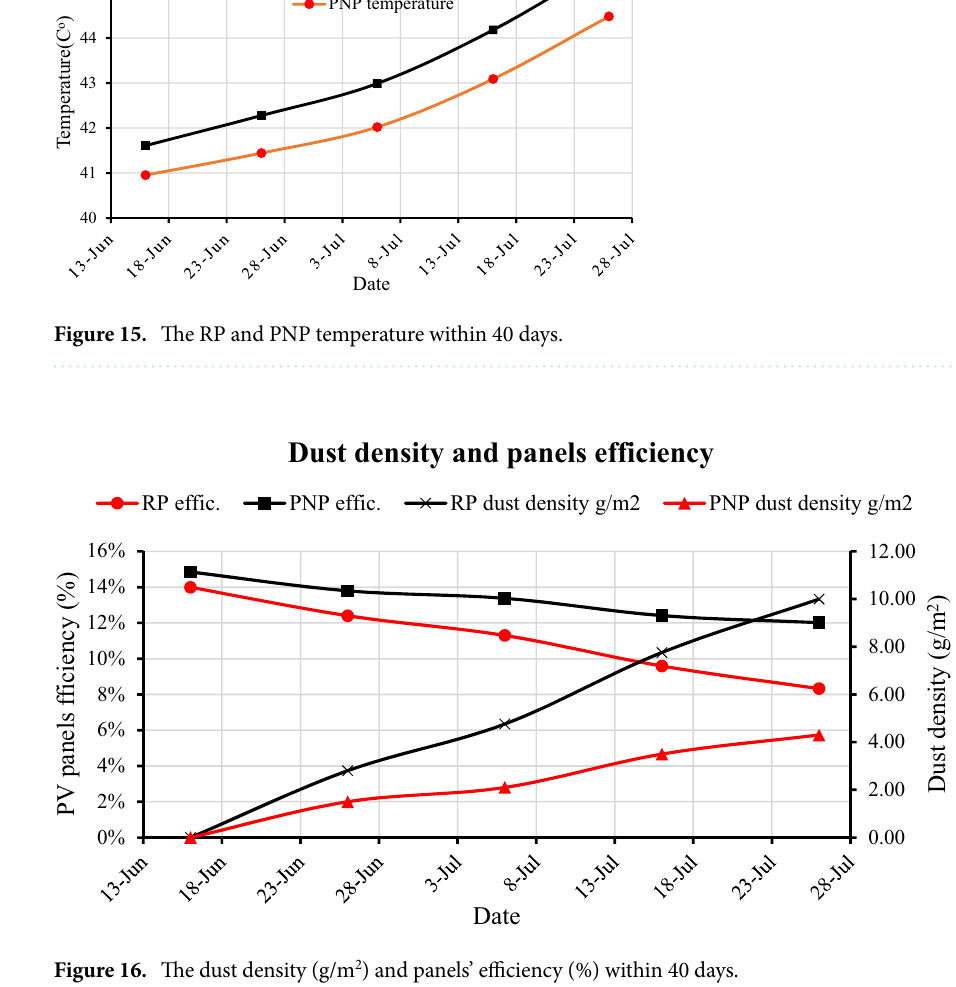
Figure 16. The dust density (g/m 2 ) and panels’ efficiency (%) within 40 days.